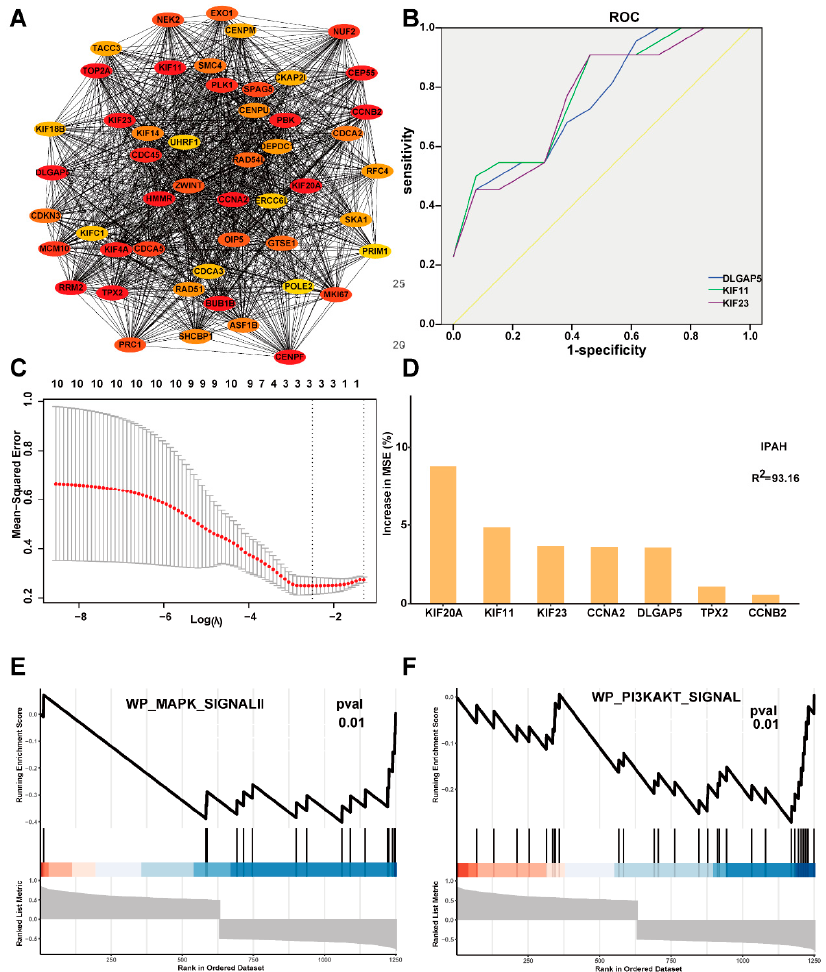
Figure 4. Identify the hub gene most related to IPAH and pyroptosis in the turquoise module. ( A ) The PPI network of top 50 hub gens. ( B ) ROC curves of top 10 hub genes. ( C ) LASSO regression of the top 10 IPAH-related genes. ( D ) SVM-RFE regression of the top 10 IPAH-related genes. ( E ) The enrichment plot of MAPK pathway. ( F ) The enrichment plot of PI3K/AKT pathway. MOCDE Plug-in screened out nine clusters in the turquoise module. In the turquoise module, cluster 1 (58 genes) was mainly associated with DNA replication, cell cycle, and mismatch repair. Cluster 2 (5 genes) was mainly associated with the chemokine signaling pathway and cytokine–cytokine receptor interaction.